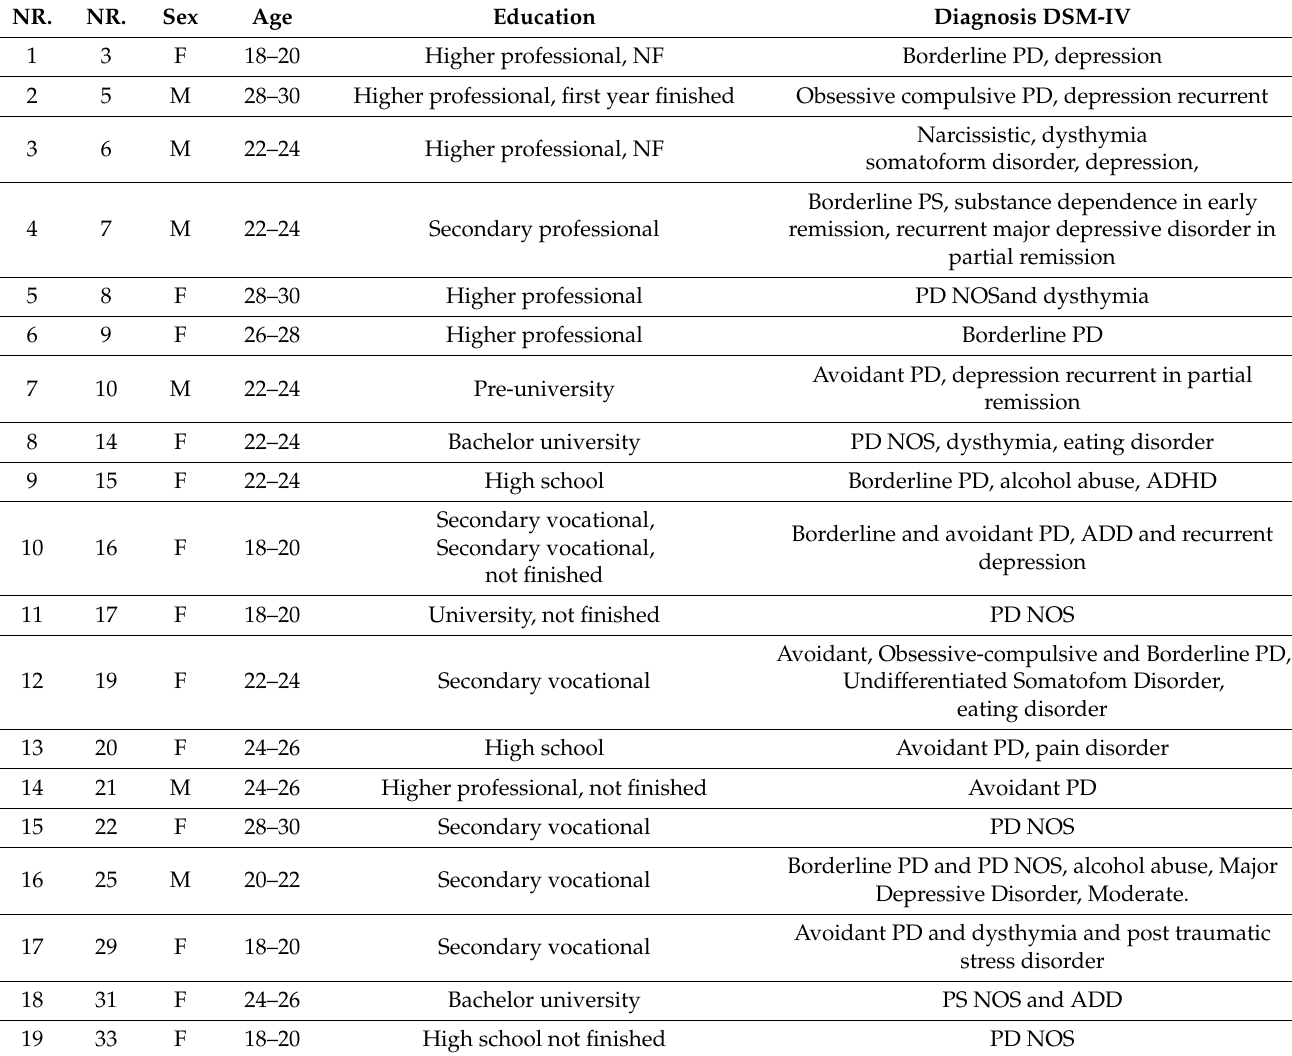
Table 8. Demographic and diagnostic characteristics of the authors of life-stories as written within the context of an intensive psychotherapy program for patients with a personality disorder